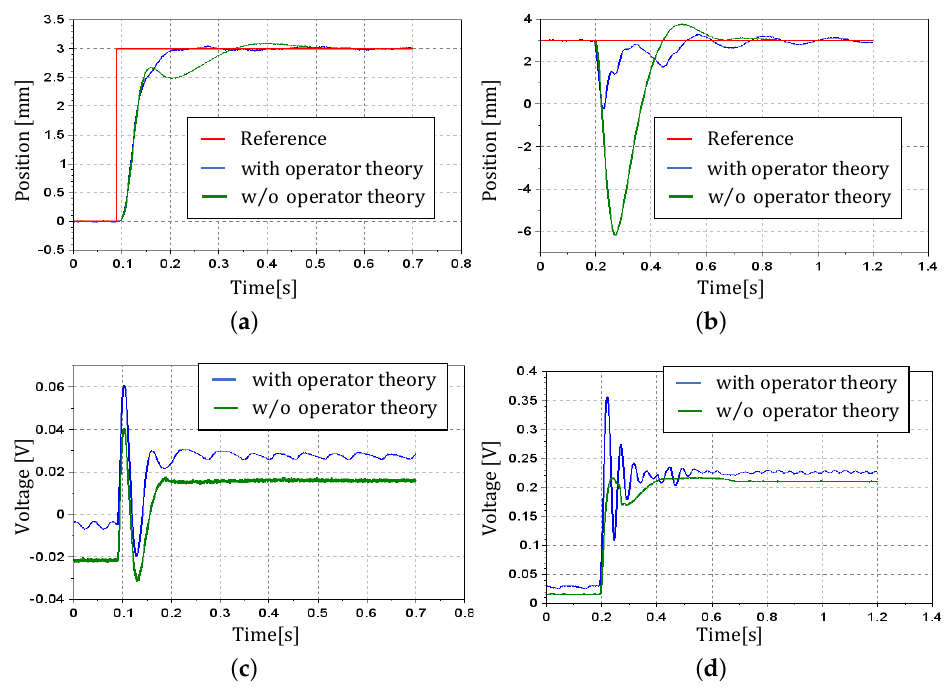
Figure 16. Experimental results w/o DOB. ( a ) Position of stage for reference. ( b ) Position of stage for disturbance. ( c ) Input voltage for reference. ( d ) Input voltage for